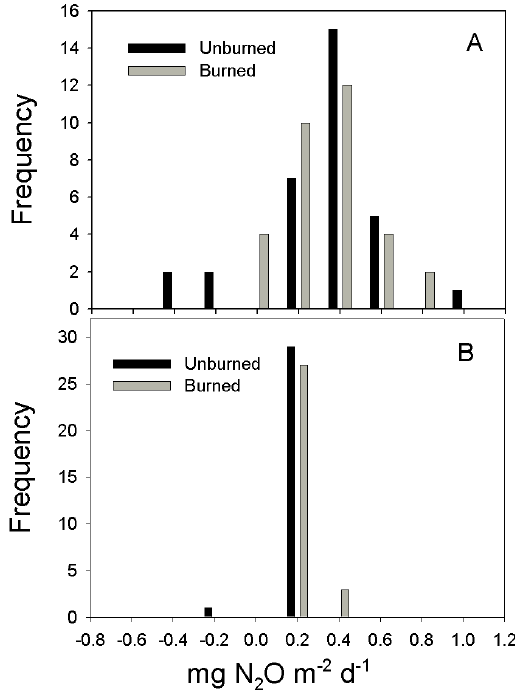
Fig. 6. The frequency distribution of single-chambers estimates of N 2 O fluxes (mgN 2 O-Nm − 2 d − 1 ) measured in unburned and burned plots (no water treatment) during the 1st campaign (A) one month after burning ( n = 32) and the 2nd campaign (B) eight months after burning ( n = 30). The range of each size class interval is 0.2mgN 2 O-Nm − 2 d − 1